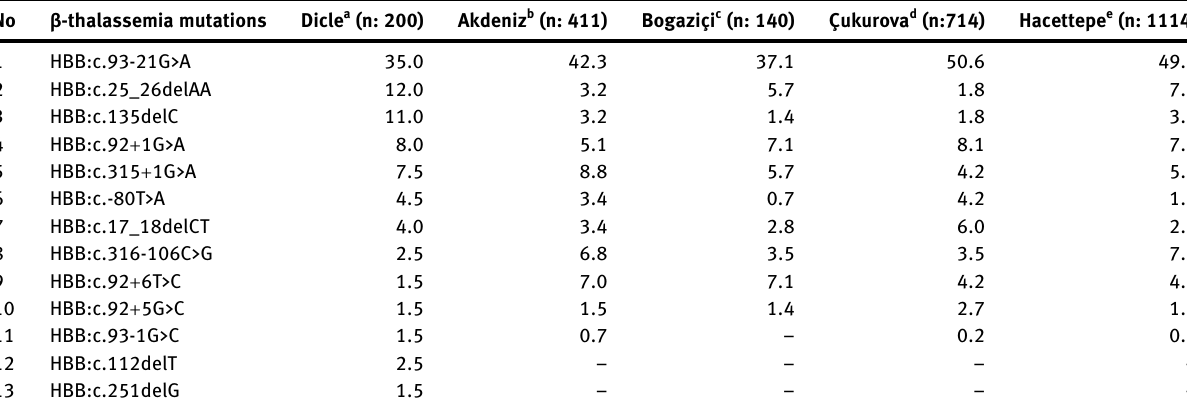
Table  : Comparison of β -thalassemia mutations in fi ve University Hospitals in Turkey. No β -thalassemia